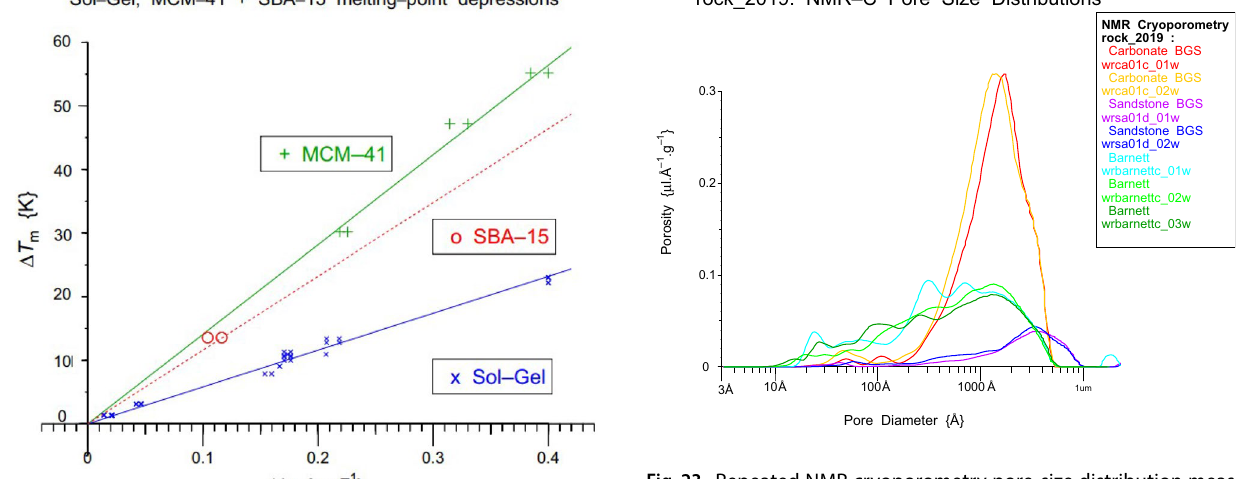
Fig. 23 Repeated NMR cryoporometry pore-size distribution meas- urements on 3 porous rocks, a Carbonate, a Barnett Shale and a